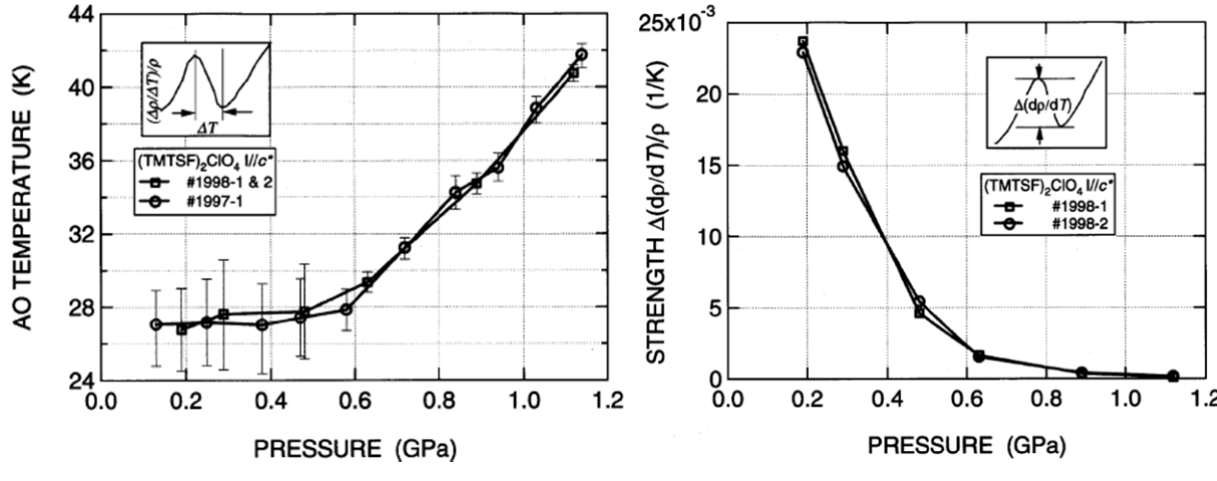
Figure 5. Temperature of anion ordering (left) and its strength (right) as a function of pressure [45]. Reproduced with permission from